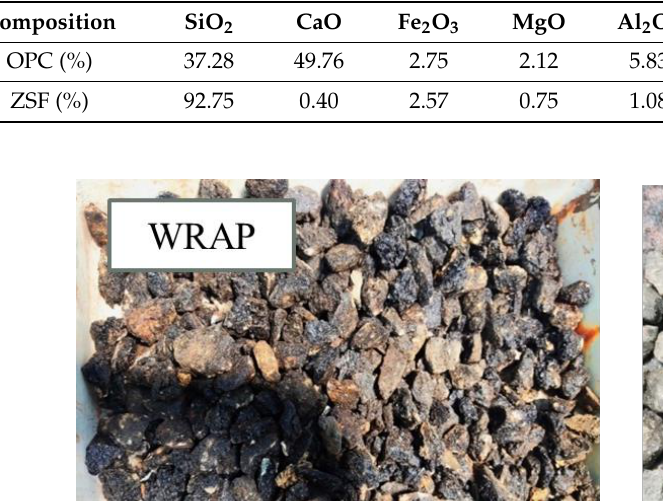
Table 2. Chemical Composition of Portland cement and ZSF admixtures.